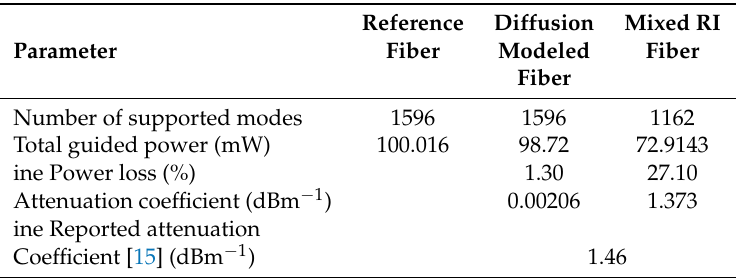
Table 6. Comparison between the power transmission parameters for a reference fiber, a CHCl 3 saturated fiber and a mixed RI fiber.